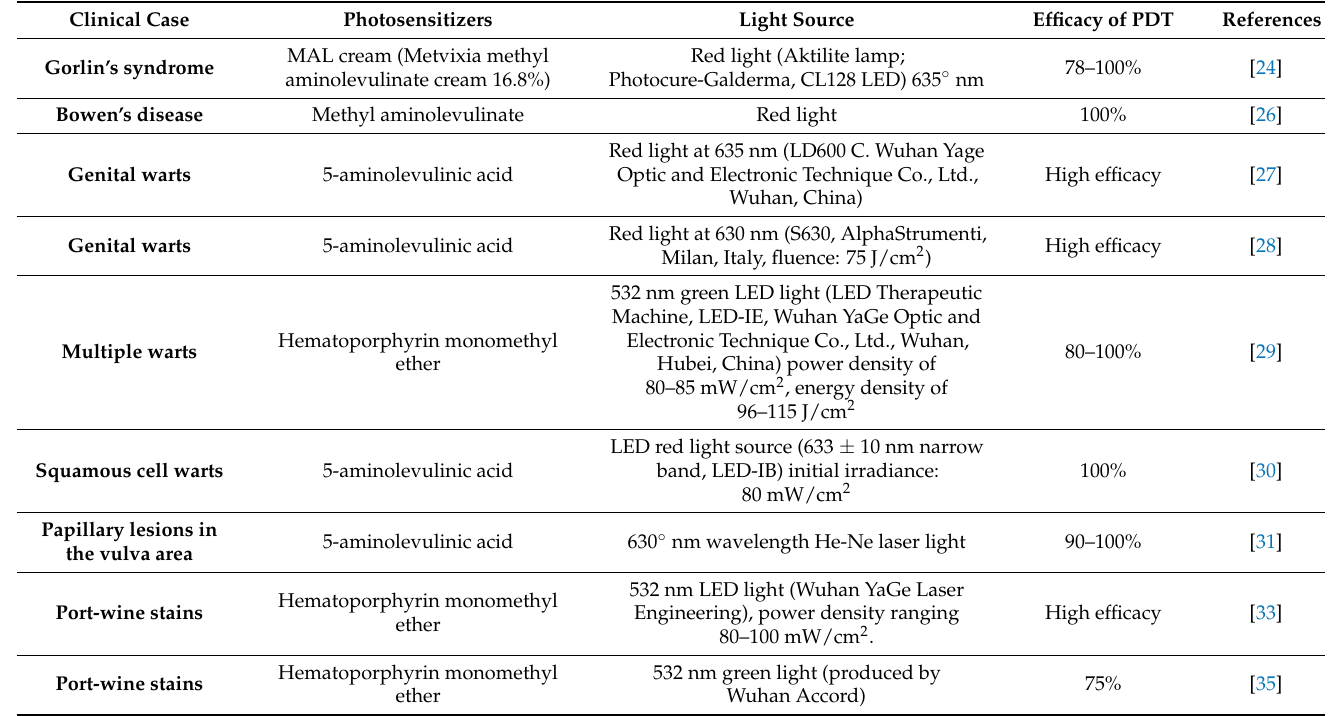
Table 1. Effectiveness of PDT